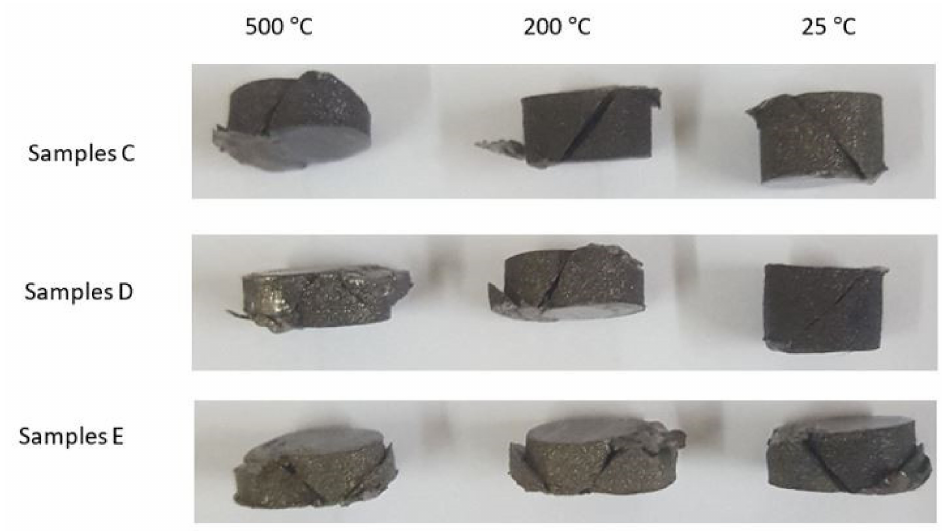
Figure 18. The photographic images of specimens deformed at a strain rate of 2450 s − 1 and at temperatures of 25, 200 and 500 ◦ C.